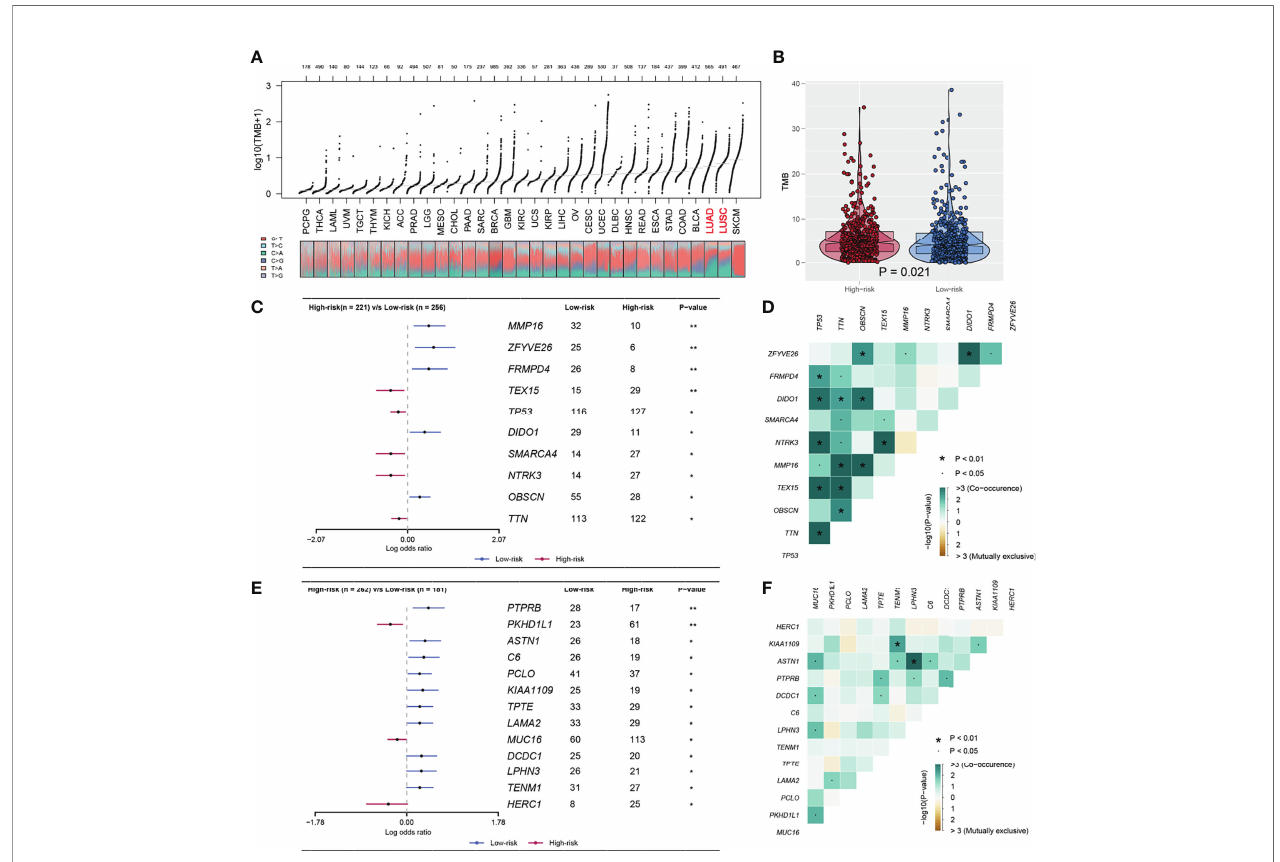
FIGURE 6 | The TMB difference between high and low IRS group. (A) The overview of TMB in TCGA-pancancer; (B) A higher TMB level was observed in high risk patients compared with the low risk patients; (C, D) The mutated gene in TCGA-LUAD between high and low risk with P < 0.05; (E, F) The mutated gene in TCGA- LUSC between high and low risk with P < 0.05. *P < 0.05, **P <